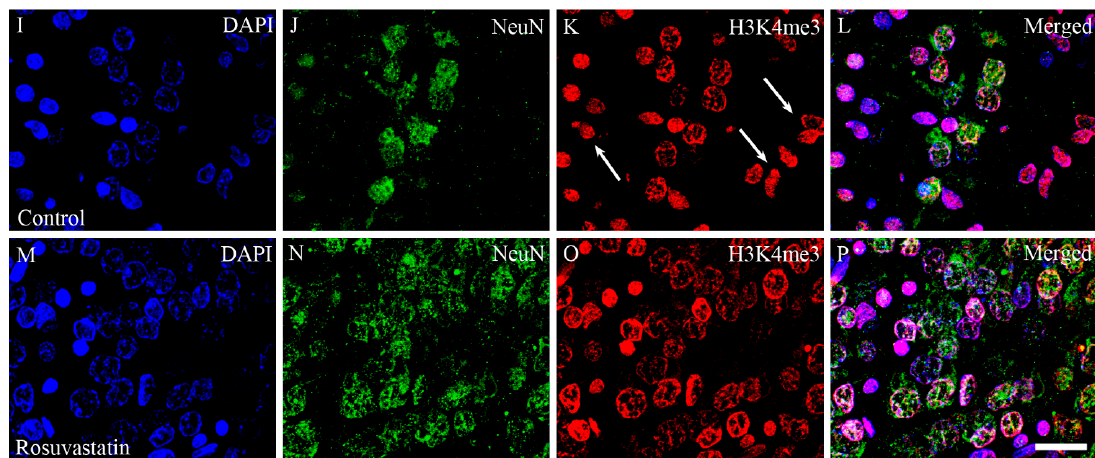
Figure 8. Laser confocal microscopy images of H3K4me1 and H3K4me3 immunoreactivities in neuronal nuclei. Paraffin sections of brains from the control ( A – D , I – L ) and RST-treated newborn rats ( E – H , M – P ) were immunostained for NeuN (shown here in green) and H3K4me1 or H3K4me3 (shown here in red), then visualized by confocal microscopy. Cell nuclei were labeled with DAPI (blue). Note the overwhelmingly neuronal localization of the histone methylation marks. Some NeuN-negative non-neuronal cells, notably in panels ( G , K ) (white arrows), also display H3K4me1 and H3K4me3 marks. Scale bar: 20 µm.